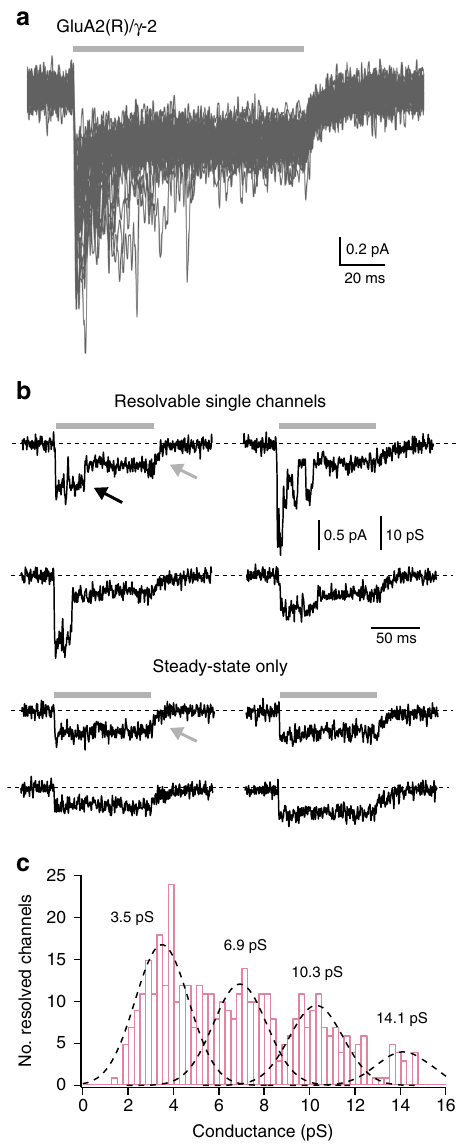
Fig. 2 GluA2(R)/ γ -2 single-channel recordings. a GluA2(R)/ γ -2 currents from an outside-out patch containing few channels ( – 60 mV). Forty consecutive applications of 10 mM glutamate (gray bar) are overlaid. b Individual responses exhibiting discrete channel openings superimposed on a persistent steady-state current (upper sweeps) or exhibiting only a persistent steady-state component (lower sweeps). Note the decay of the steady-state currents on glutamate removal (gray arrows) is much slower than the closure of resolved channels (black arrow). c Histogram of channel conductance for 392 discernible openings from six patches. The histogram is fi t with the sum of four Gaussian curves (dashed lines) with a common standard deviation (1.2 pS), revealing four peaks (3.5, 6.9, 10.3, and 14.1